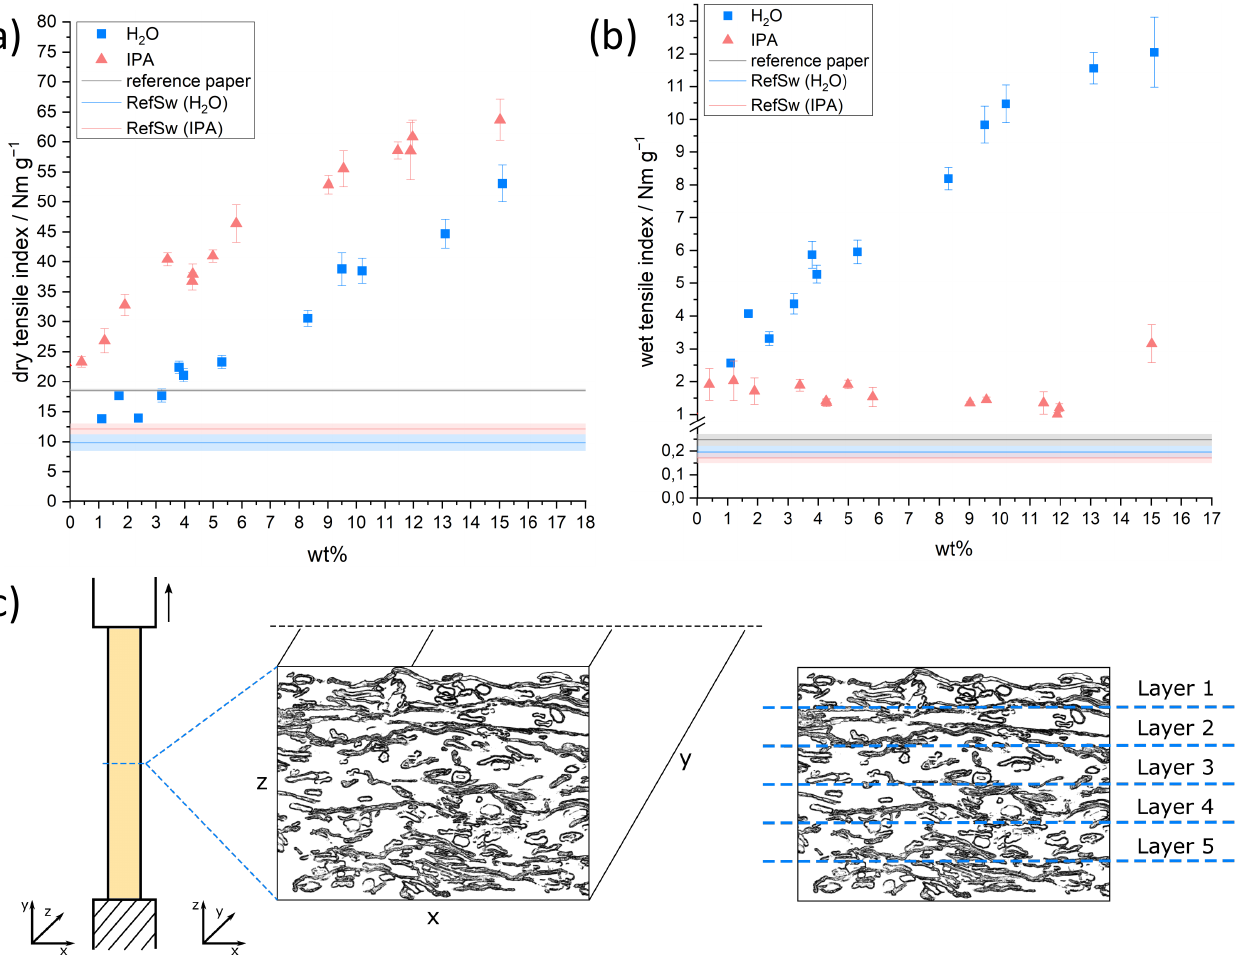
Figure 9. Dry ( a ) and wet ( b ) tensile index values of paper samples impregnated with copolymer solutions of varying concentrations and the two solvents H 2 O (blue squares) and IPA (peach triangles), respectively. As a point of reference, three tensile index values of pure reference eucalyptus paper (reference paper), and paper samples that were treated in analogy to the copolymer application, but without any polymer, in the solvents used for the initial swelling step with H 2 O (RefSw—H 2 O) and IPA (RefSw—IPA), respectively. ( c ) Schematic representation of a paper sheet during tensile testing, focusing on the “quasi-layers” of fiber–fiber bonds in the z-direction. The paper was sectioned into five layers in the thickness direction, in order to keep the image